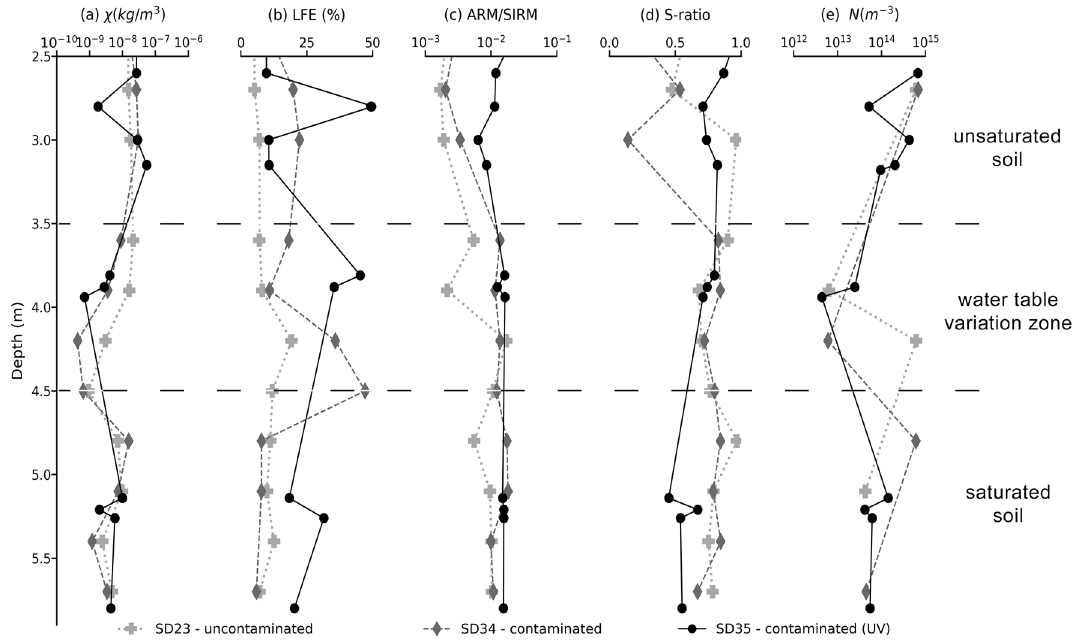
Figure 5. Magnetic properties depth profiles of SD23 (uncontaminated), SD34 and SD35 (contaminated) boreholes. ( a ) MS at the frequency 976 Hz; ( b ) Frequency effect represented by the LFE parameter; ( c ) ARM/ SIRM ratio; ( d ) S-ratio and ( e ) number of SP grains. While ( a ) shows how magnetic the samples are, ( b ) and ( c ) reveal the magnetic signature of the finer magnetic carriers in the samples, ( d ) reveals the occurrence of magnetic minerals of different coercivities and ( e ) gives a quantification of the ultrafine